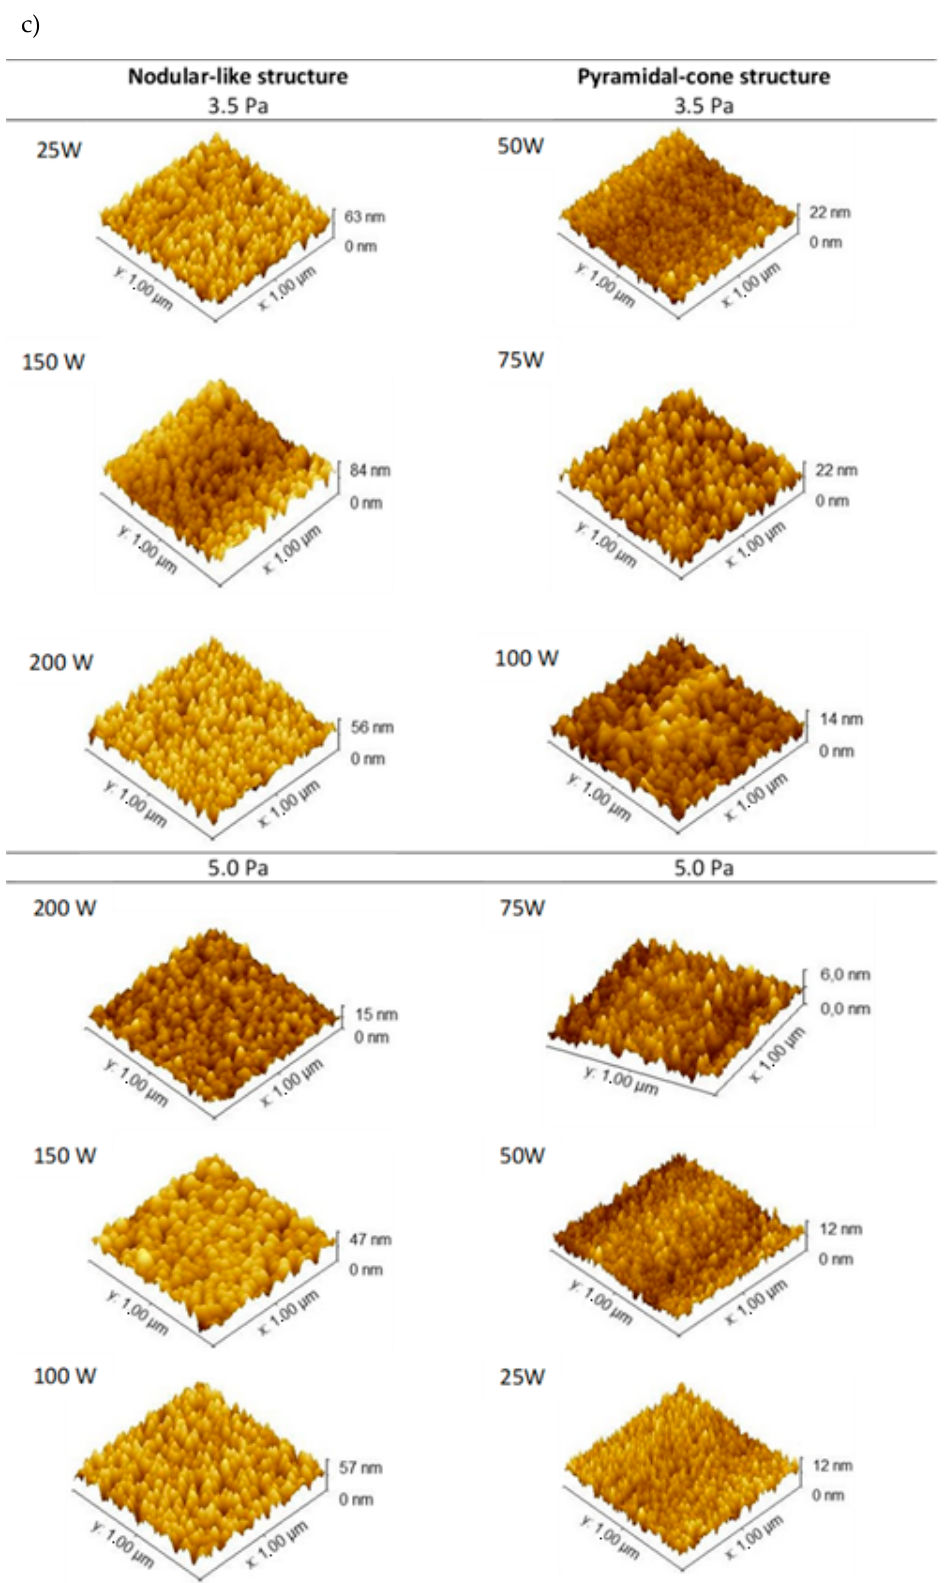
Figure 5. 1 × 1 μ m 2 2D AFM micrographs of the sputtered Cu 3 N films deposited at different RF powers and at ( a ) 3.5 Pa and ( b ) 5.0 Pa; ( c ) 1 × 1 μ m 2 3D AFM micrographs divided depending on the type of morphology.